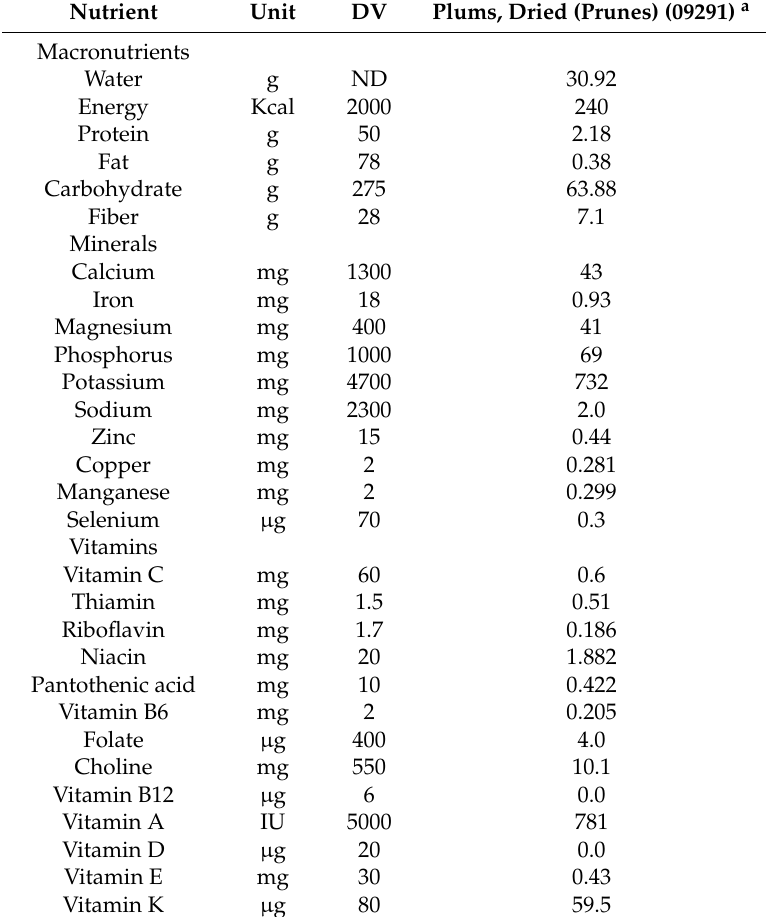
Table 1. Nutritional profile of dried plums per 100